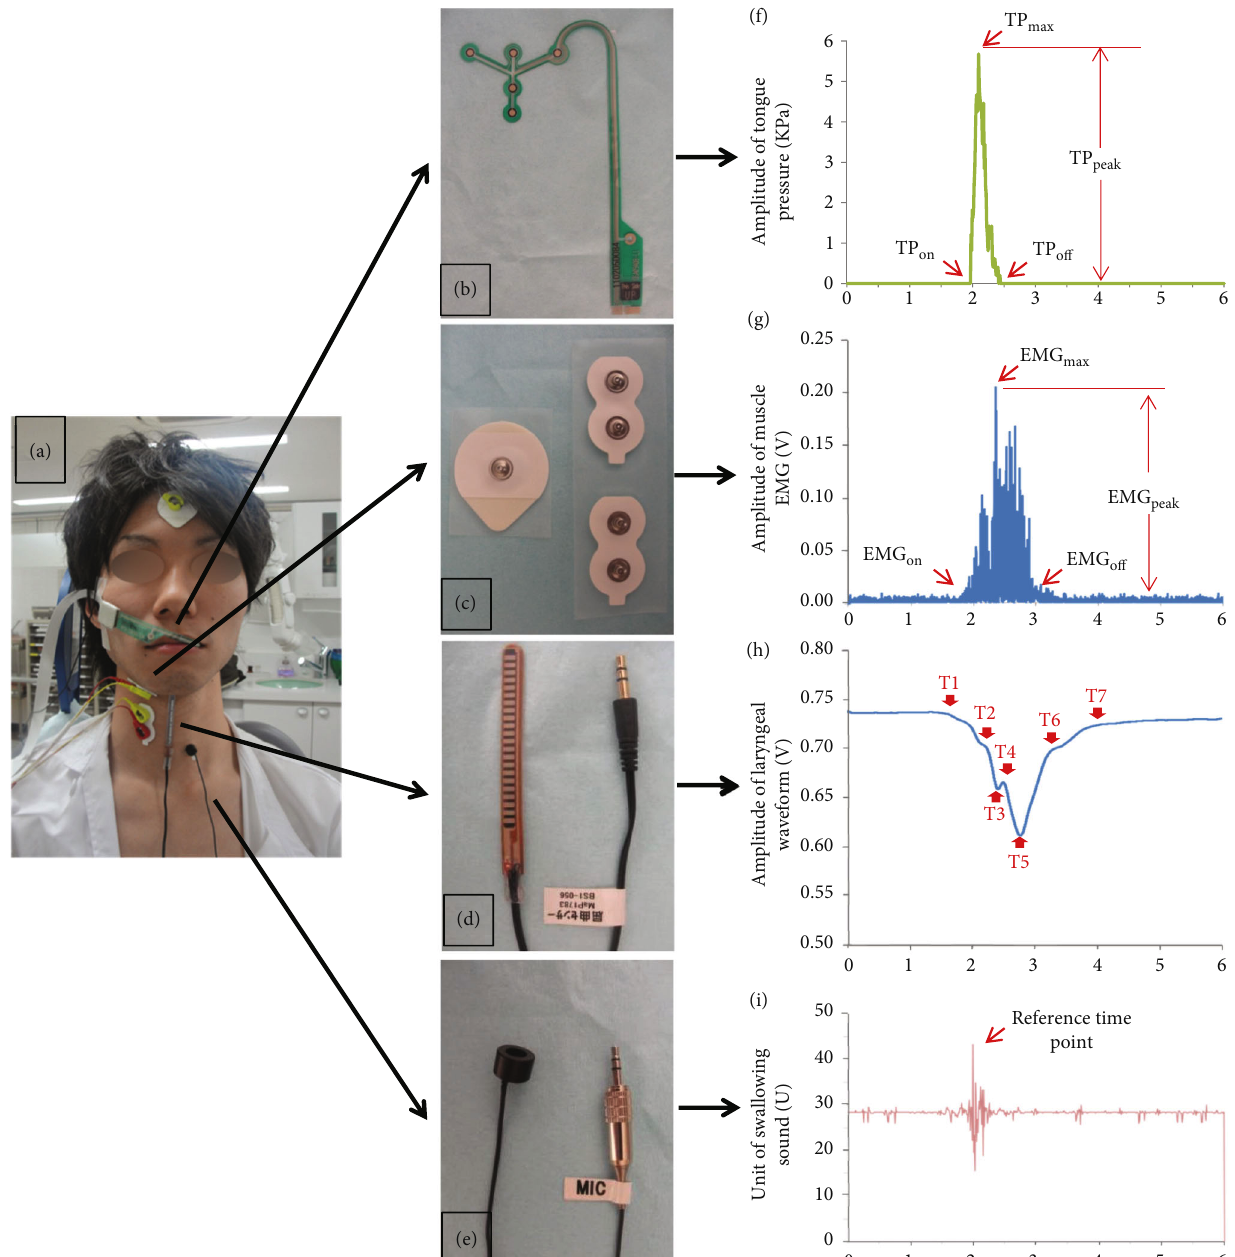
Figure 1: Schematic representations of the sensing system and recordings. (a) A subject with tongue pressure sensor sheets, surface electrodes, bend sensors, and microphones. (b) Tongue pressure sensor sheet. (c) Surface electrodes. (d) Bend sensor. (e) Microphone. (f) The tongue pressure waveform. (g) The EMG of swallowing-related muscle. (h) The laryngeal signal waveform and marked time point. , onset of tongue pressure; TP , time of maximum tongue pressure; TP , o ff set of tongue (i) The swallowing sound waveform. TP on max o ff , peak value of tongue pressure; EMG , onset of electromyography; EMG , time of peak electromyography, EMG , pressure; TP peak on max o ff , peak value of electromyography; T1, onset of hyoid slight movement; T2, onset of hyoid rapid o ff set of electromyography; EMG peak movement; T4, onset of stationary phase of the hyoid; T5, o ff set of the stationary phase of the hyoid; T6, o ff set of hyoid movement. T3 and T7 were con fi rmed to be meaningless for hyoid